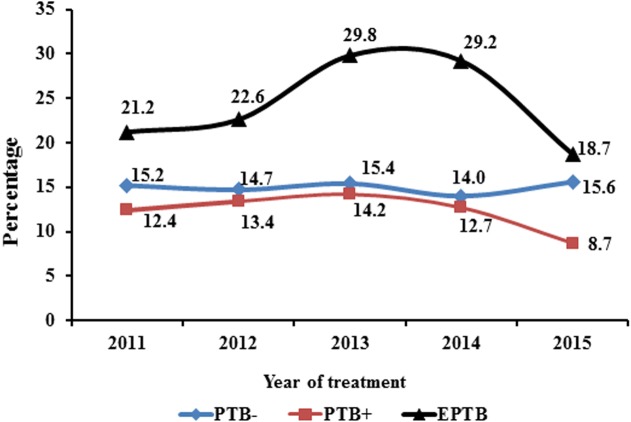
Trend of type of TB during 5 years of study.PTB−, smear negative pulmonary TB; PTB+, smear positive pulmonary TB; EPTB, extra-pulmonary TB. Trend of different types of TB were noticed for children from 2011 to 2015. There was a slight variability was seen for PTB−. The maximum fluctuation was observed for EPTB starting from 21.2% reaching up to 29.8% and then finally declining to 18.7%. A decreasing trend was seen for PTB+ among children.